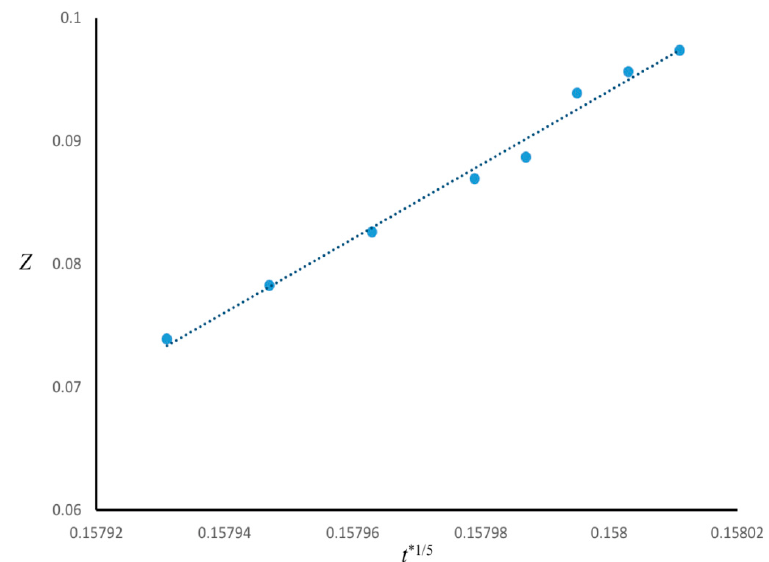
Figure 3. Growth of surface enrichment layer as a function of t * 1/5 for Case 1.